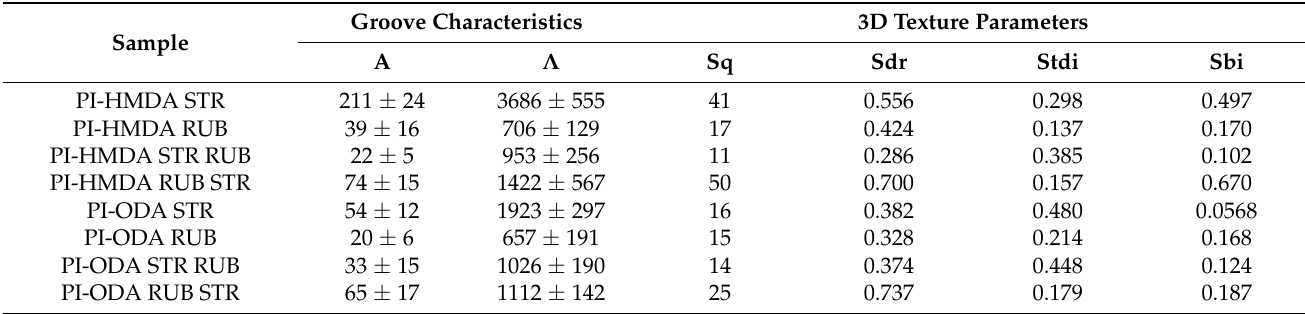
Table 2. Groove characteristics and 3D texture parameters obtained for polyimides PI-HMDA and PI-ODA after stretching (STR), rubbing (RUB), rubbing after stretching (STR RUB), and stretching after rubbing (RUB STR).